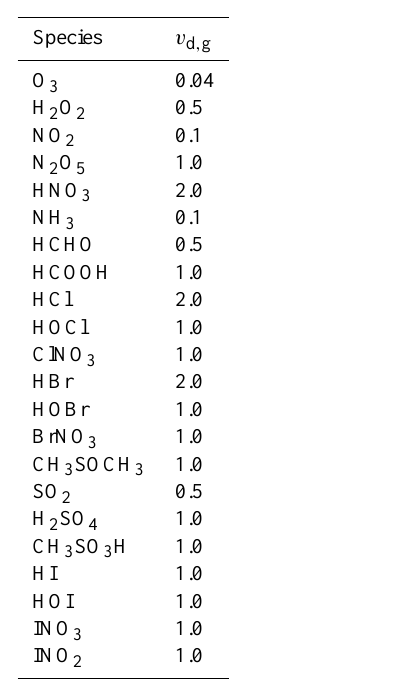
Table 4. Gas-phase loss velocities, v d , g , in cms − 1 . Representing deposition at base of model column (estimated, consistent with es- timations used in other models).